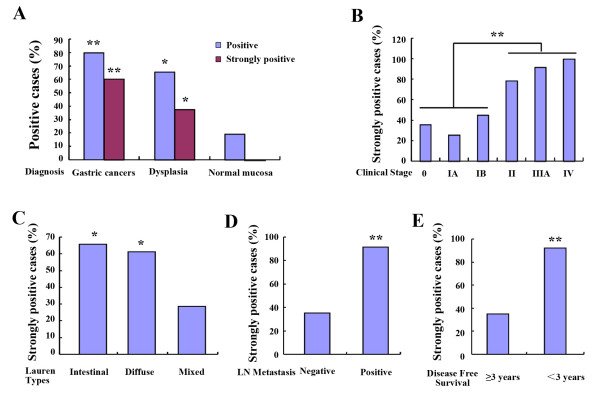
Ezrin protein showed significantly higher positivity in gastric adenocarcinoma and dysplasia compared with the adjacent normal gastric mucosa (A), and its expression level was significantly higher in the late stage (Stage II, Stage III, and Stage IV) of gastric cancers than it in the early stage (Stage 0, Stage IA, and Stage IB) cases (B). Moreover, strongly expression of Ezrin protein was detected in Lauren intestinal and diffuse type of gastric adenocarcinomas than it in the mixed type cases (C). Ezrin protein overexpression showed closely correlation to the metastatic status (D) and disease free survival of gastric adenocarcinoma (E).